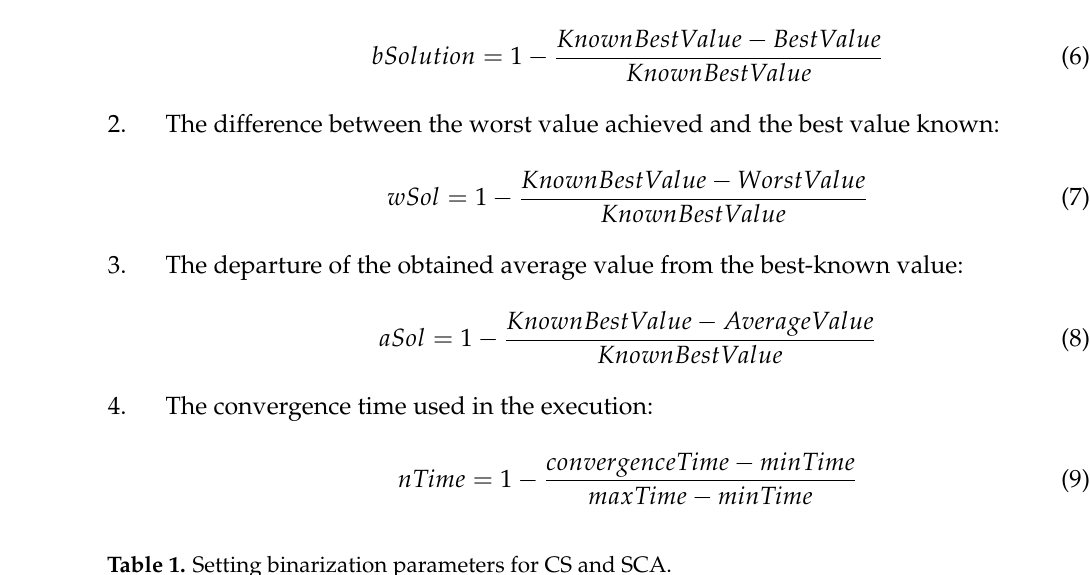
Table 1. Setting binarization parameters for CS and